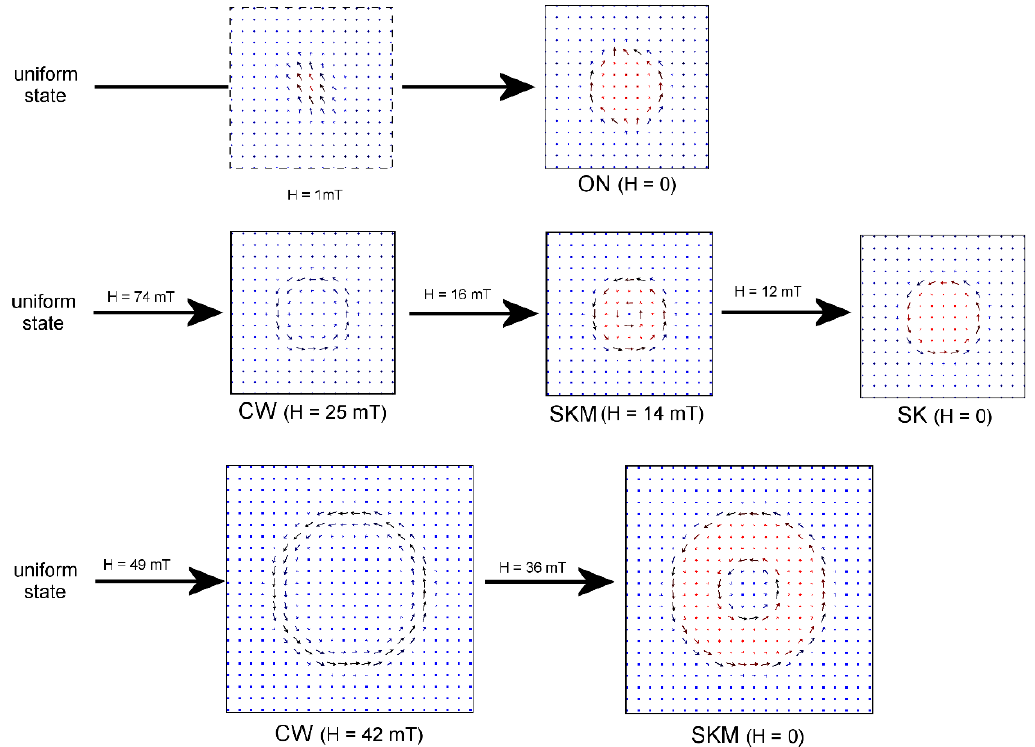
Figure 4. (Color online) The schematic representations of the magnetization state transformations in the unit cell of the spots lattice during the magnetization reversal (results of numerical simulations). The upper line is for the system with uniform anisotropy within a spot (sample 1, D 1 = 100 nm, a = 200 nm). ON stands for onion state. The middle line is for the sample with concentric distribution of the anisotropy (sample 2, D 2 = 100 nm, a = 200 nm). The bottom line corresponds to the sample 3 ( D 1 = 200 nm, a = 300 nm). CW means circular wall, SKM stands for skyrmionium, and SK is for skyrmion. The field values shown above the arrow correspond to the transition between di ff erent states. The field at which a particular magnetization distribution is obtained is shown below the corresponding distribution. The image surrounded by a dotted line does not show a stable state but an instant snapshot of the magnetization turnover in the uniformly irradiated